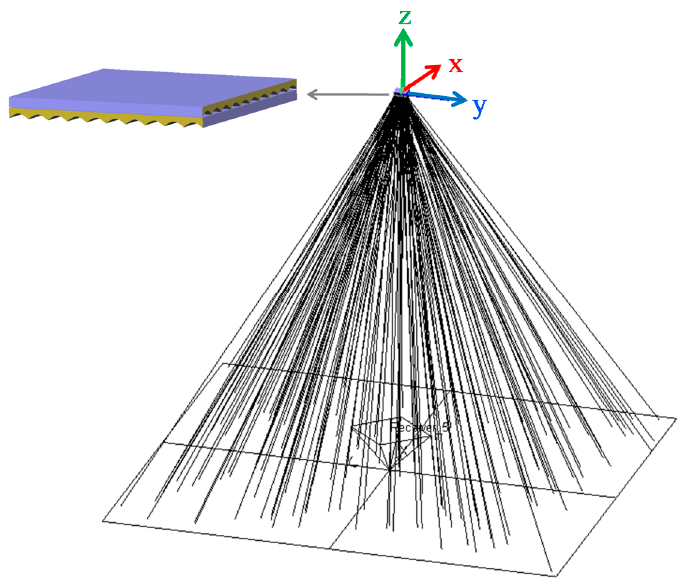
Figure 10. The distributor using two divergent linear Fresnel lenses distributes the sunlight on two dimensions.